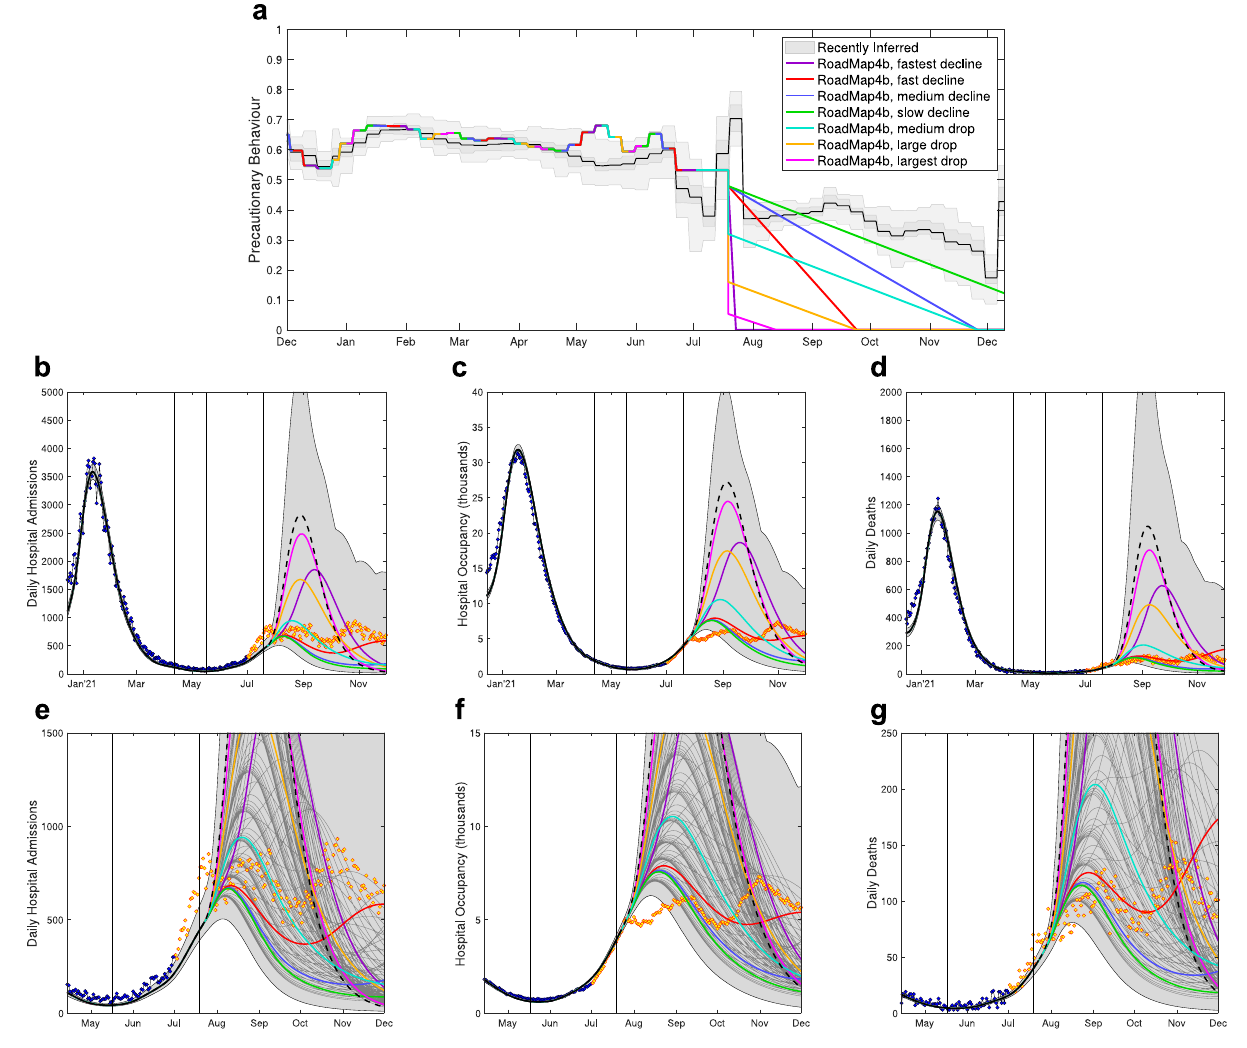
Fig.7|SeverediseaseprojectionsfromRoadmap4bFigure5 17 ,whichshowsthe projections associated with seven assumptions about Step 4 precautionary behaviour. a The most recently inferred level of precautionary behaviour (grey, showing mean, 50% and 95% credible intervals) together with the seven different assumptions from Roadmap 4b. The lower panels show daily hospital admissions b , e , hospital occupancy c , f and daily deaths d , g for the seven main assumptions (colouredlinesgivingthemedianvalues)andforthenaiveassumptionofanabrupt